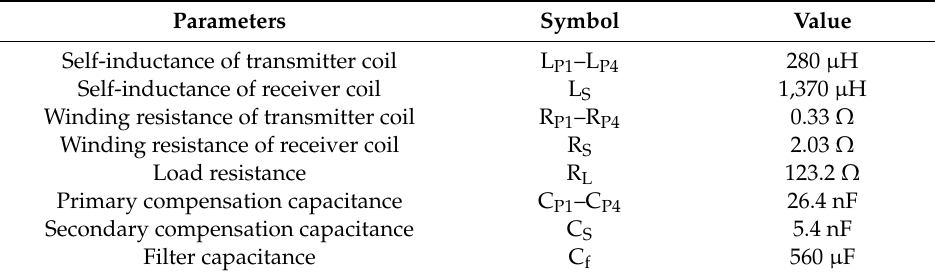
Figure 16. Experimental setup: ( a ) Overall system; ( b ) Multiple transmitter coils; ( c ) Single receiver coil. Table 2. Measured circuit